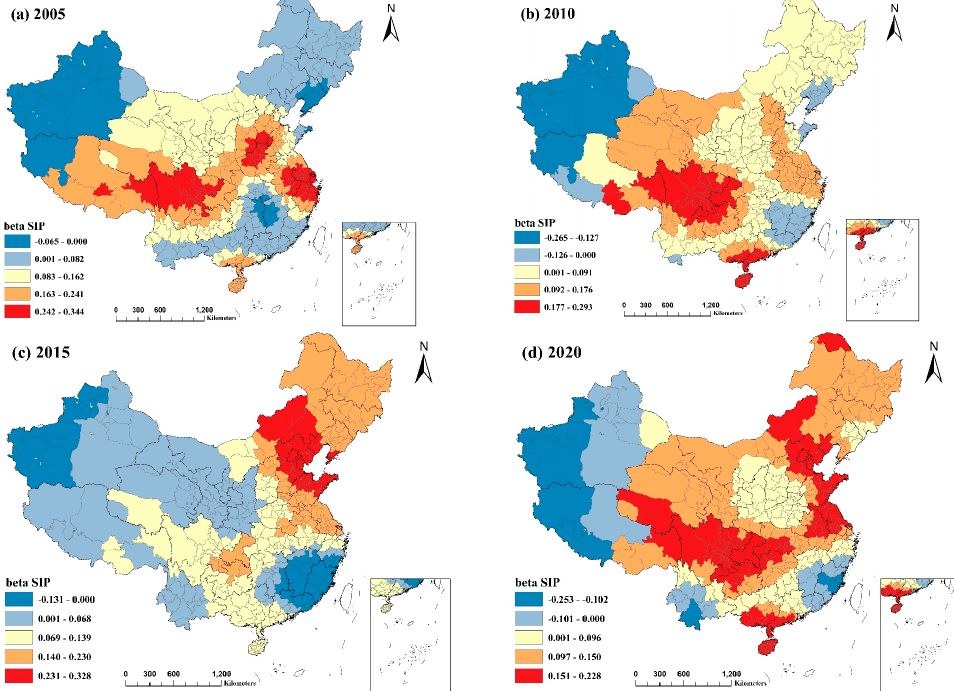
Figure 7. Spatial and temporal distribution of regression coefficients of the proportion of the sec- ondary industry in the MGWR model, 2005 − 2020: ( a ) spatial and temporal distribution of regression coefficients for the proportion of the secondary industry in 2005; ( b ) spatial and temporal distribution of regression coefficients for the proportion of the secondary industry in 2010; ( c ) spatial and temporal distribution of regression coefficients for the proportion of the secondary industry in 2015; ( d ) spatial and temporal distribution of regression coefficients for the proportion of the secondary industry in 2020.